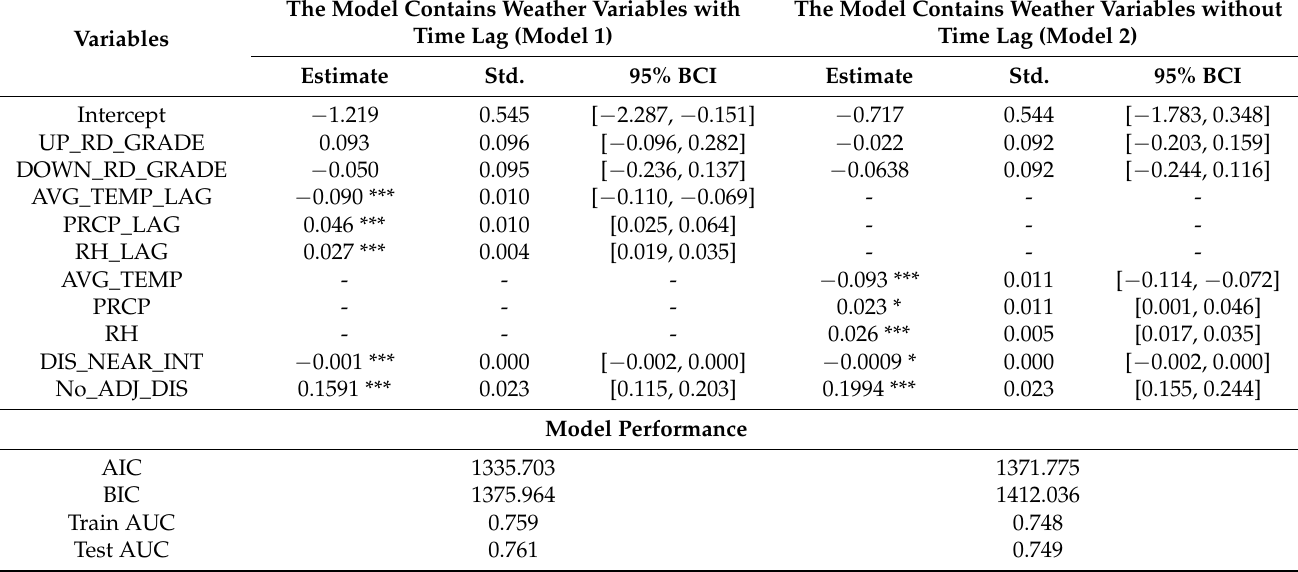
Table 3. Results of Bayesian Logistic Regression